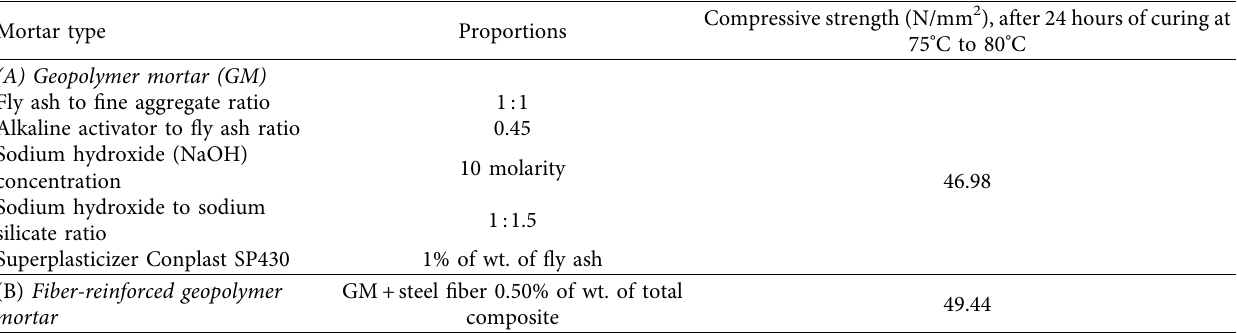
Table 3: Mix proportions of the geopolymer mortar.